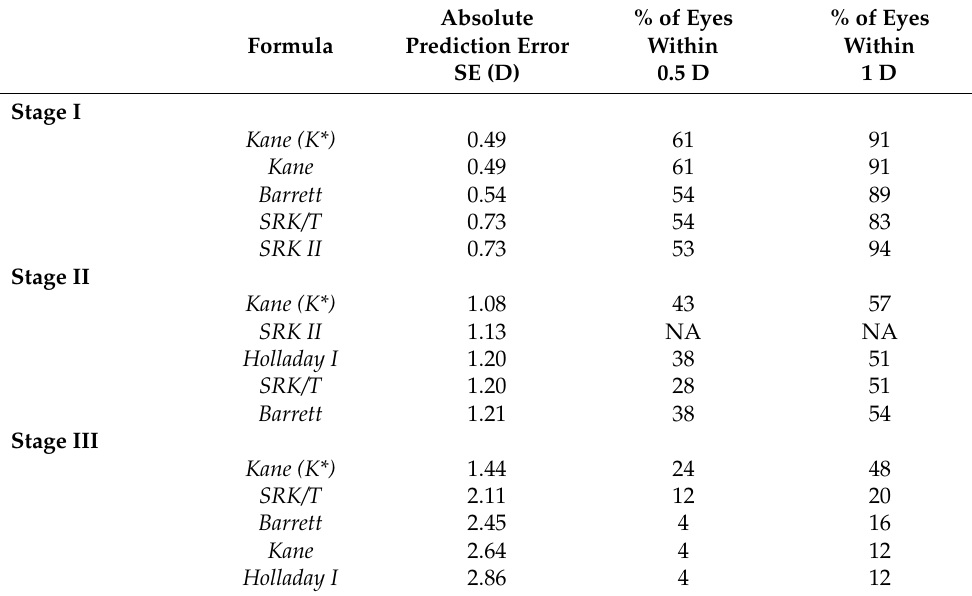
Table 5. Weighted absolute prediction errors for top five IOL formulas in each KC